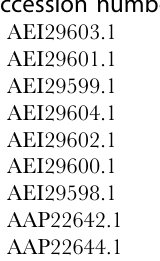
Figure S1 Aligned translated sequences of eight newly identified VHHs. Eight novel Nbs selected by phage display and panning against T. brucei AnTat1.1 sVSG. Complementarity determining regions (CDR) 1–3 are indicated above the sequences. (TIF) Figure S2 Aligned translated sequences of three novel Nb_An33 variants. Three Nb_An33 variants (Nb_An33mut1-3 as compared to the wildtype Nb_An33) were randomized in selected positions in CDR1 or CDR3 and selected through phage display and panning. CDR1 to 3 are indicated above the sequence.